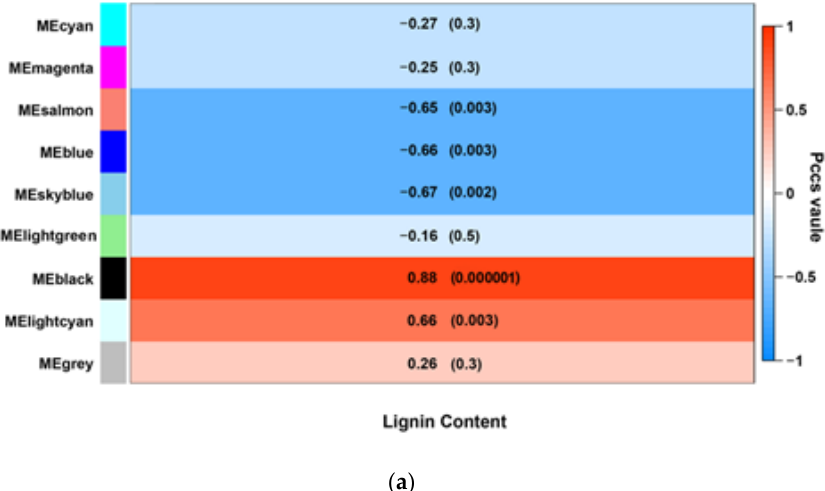
Figure 5. ( a ) The lignin metabolic pathway in pomelo; ( b ) Heatmap of lignin biosynthesis genes in NC and FC juice sacs at three stages; ( c ) The expression level of 20 DEGs related to lignin metabolism was based on the FPKM value. FPKM values were the means of three replications.